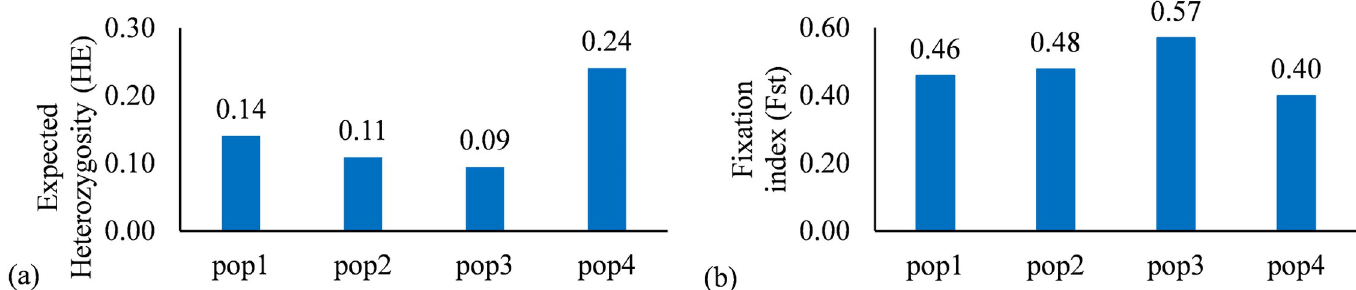
Fig 6. Genetic variation within the subpopulations. (a) Average distances (Expected Heterozygosity) between individuals in same cluster. (b) Genetic variation within the subpopulations (Fst).